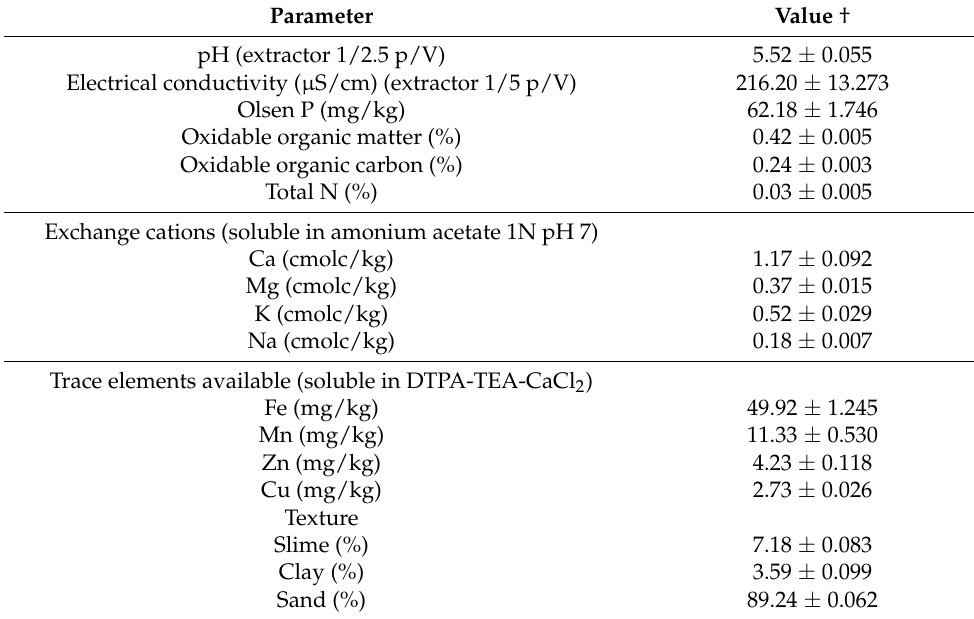
Table 1. Physicochemical soil properties.